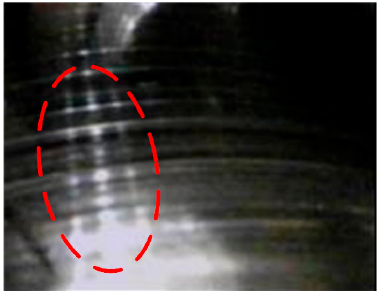
Figure 13. The inner ring of the bearing in the high stage of the gearbox.